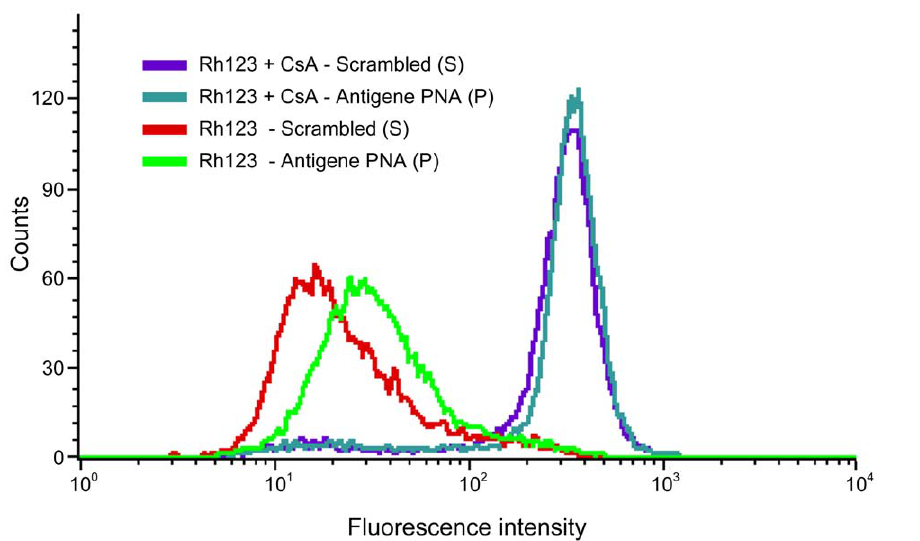
Figure 3. KB-8-5 cells were transduced with IVP-scrambled (S) or IVP-antigene PNA (P) and the P-gp-mediated efflux capacity was measured through the efflux of the fluorescent dye Rhodamine 123 (Rh123), in the presence or absence of a P-gp inhibitor, cyclosporin A (CsA). The coincident histograms of cells transduced with S or P and treated with CsA demonstrate effective P-gp inhibition. In the absence of inhibitor, cells transduced with P show a significant decrease in efflux capacity, evidenced by greater intracellular fluorescence, as compared to cells transduced with S .